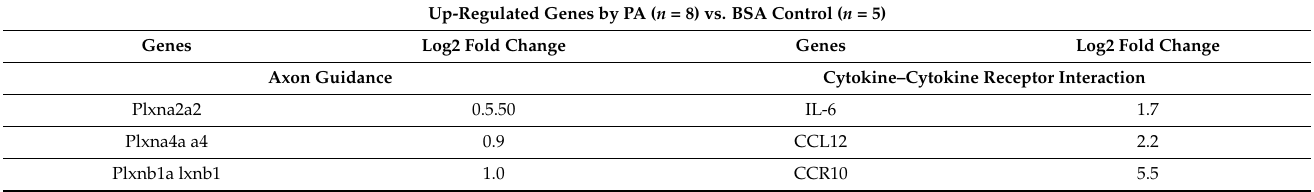
Figure 6. Volcano plot of differentially expressed genes regulated by in vivo PA treatment in TLR9- sufficient and -deficient mouse lung macrophages. ( A ) Genes changed (up- or down-regulated) or not changed (NO) in TLR9-sufficient macrophages treated with PA ( n = 8) versus the BSA control ( n = 4). ( B ) Genes changed (up- or down-regulated) or not changed (NO) in TLR9-deficient ( n = 8) versus TLR9-sufficient ( n = 8) macrophages treated with PA. Table 2. List of genes in selected pathways altered by palmitic acid in wild-type mouse lung mac- rophages. Up-Regulated Genes by PA ( n = 8) vs. BSA Control ( n = 5) Genes